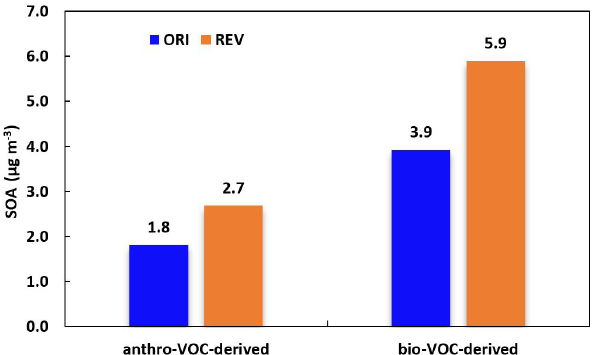
Figure 5. Predicted monthly average SOA concentration from an- thropogenic VOCs (anthro-VOC-derived) and biogenic VOCs (bio- VOC-derived) in Beijing. Numbers in this figure only include SOA from representative anthropogenic or biogenic